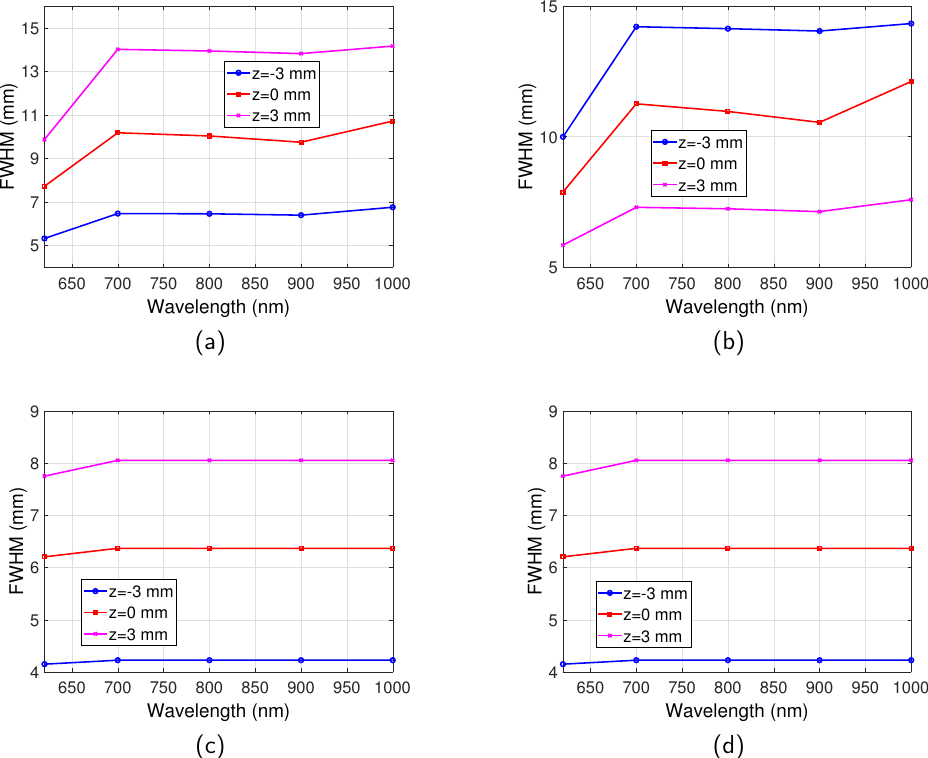
Figure 6. Spatial resolution for full-field illumination system and scanning system as a function of wavelength. Optical properties are the same as those indicated by Figure 2. Separation between the two targets is D = 16mm. λ ex = 600nm. ( a ) FWHM vs. λ em for full-illumination system in reflection mode. ( b ) FWHM vs. λ em for full-illumination system in transmission mode. ( c ) FWHM vs. λ em for scanning system in reflection mode. ( d ) FWHM vs. λ em for scanning system in transmission mode.